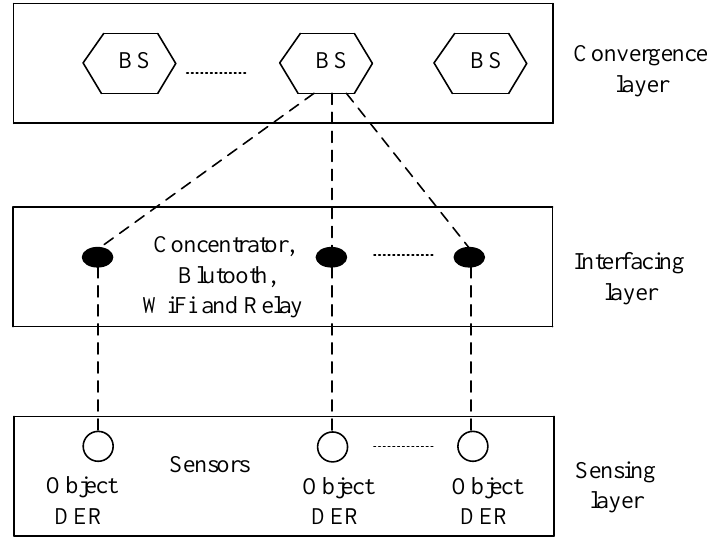
Figure 6. Example of the system framework for smart grids